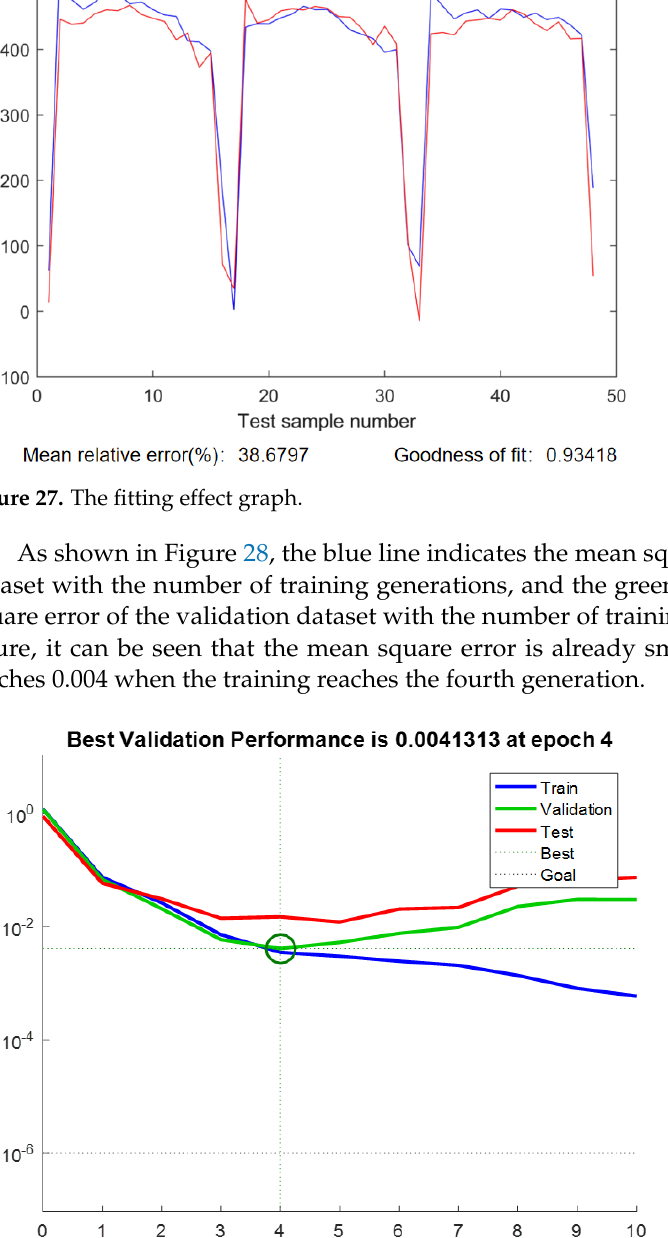
Figure 29. Gradient curve graph. Figure 30 depicts the tracking of the output of the load prediction network model with respect to the target output. The blue line shows the tracking of the training set, and the black line shows the overall tracking. It can be clearly seen that the linear correlation between the prediction model output and the actual measurements is 0.95, which indi- cates a high linear correlation.